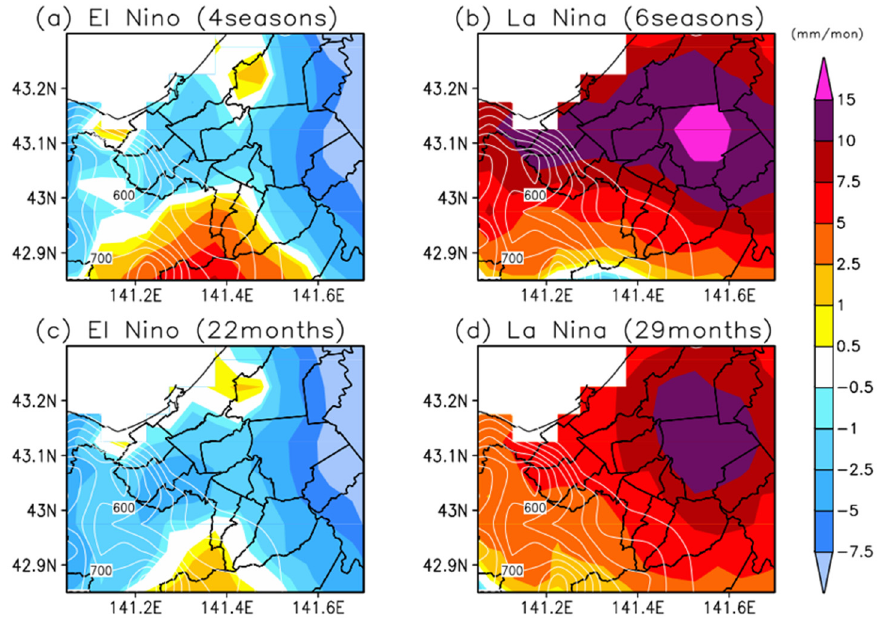
Figure 14. Seasonal and monthly precipitation composite anomalies. Color scale is the same for the four panels, and white contours indicate elevation. ( a ) El Niño winter (1998, 2003, 2010, and 2015) composite anomaly, and ( b ) La Niña winters (1996, 1999, 2000, 2006, 2008, and 2011). ( c ) El Niño winter monthly composite and ( d ) La Niña winter monthly